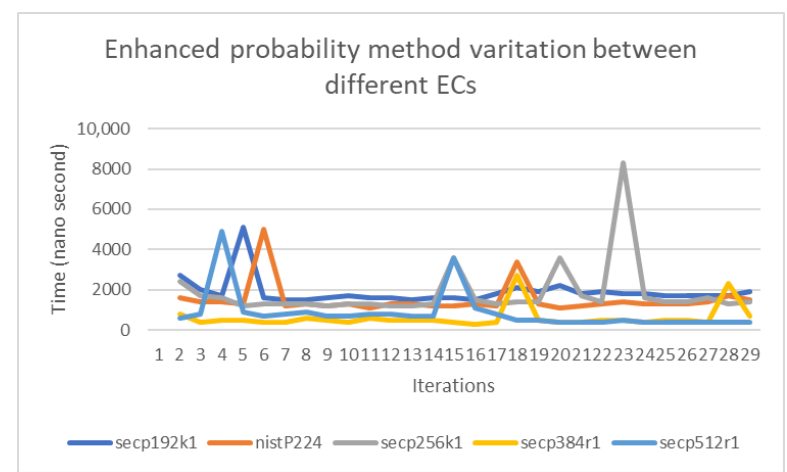
Figure 16. The variation between the set of Elliptic Curves (ECs) in the enhanced probability method.